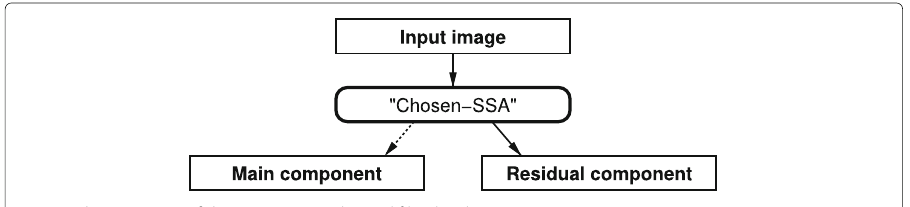
Fig. 4 The structure of the “ SSA-iSBD2-channelfilterbank